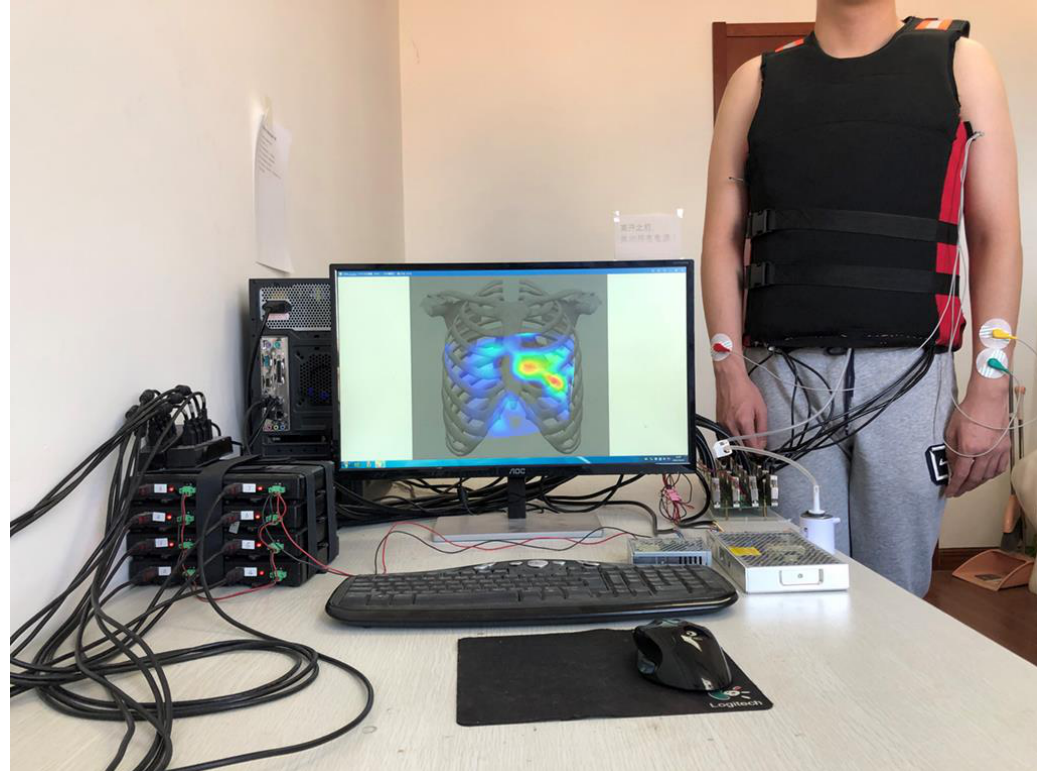
Figure 4. Multi-channel wearable heart sound acquisition device. ( a ) Sensor PCB, ( b ) rubber hous- ing, ( c ) packaged sensor, ( d ) ECG AFE, ( e ) size of the sensor and the PCB, (f) vest and the sensors arrangement on the inside of the vest.